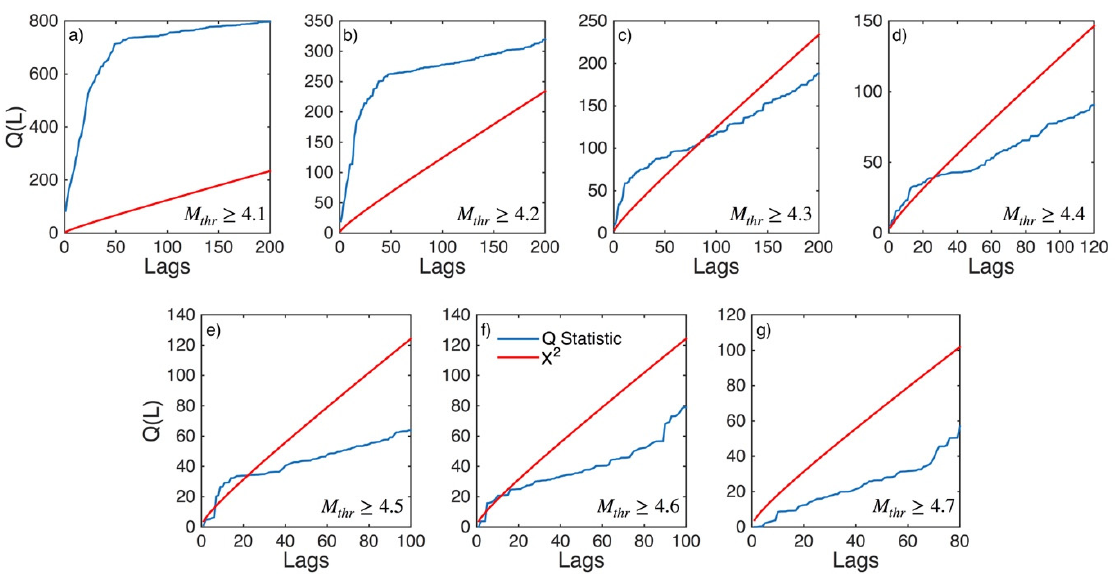
Figure A14. PACF values (orange stems) and their 95% confidence intervals (blue lines) for Southwest Aegean Sea and Peloponnese (sub − area 6) for magnitude thresholds ( M thr ) varying from 4.1 to 4.7 (subplots a – g ).